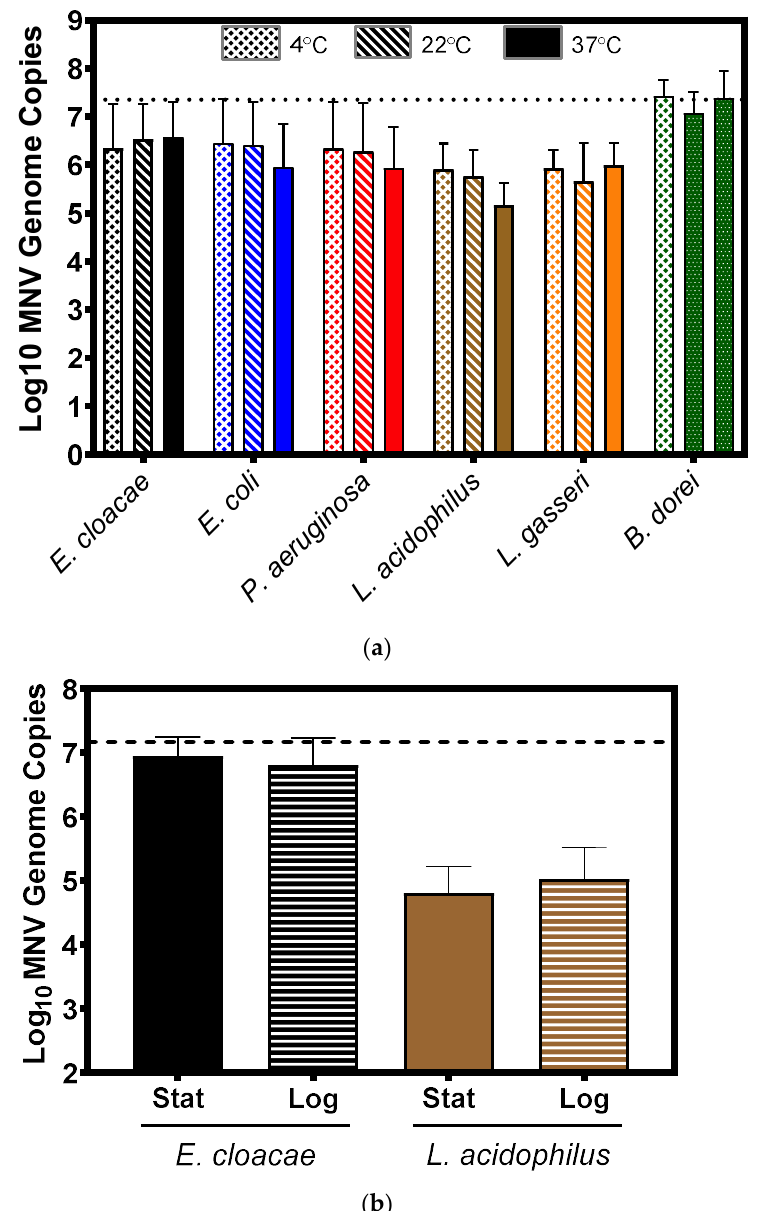
Figure 4. Impact of thermal incubation conditions and bacterial growth phase on murine norovirus attachment to bacteria. ( a ) Changes in incubation temperature (4, 22 and 37 ◦ C) did not significantly alter MNV attachment to any of the tested bacteria. Statistical analysis was performed using a paired Student’s t test in GraphPad Prism. ( b ) Bacterial growth phase—log or stationary—did not significantly ( p > 0.05) alter MNV attachment to either E. cloacae or L. acidophilus . The attachment was determined by the amount of viral genome copies found by RT-PCR. For all experiments and treatments, n = 3. Statistical analysis was performed using a paired Student’s t test in GraphPad